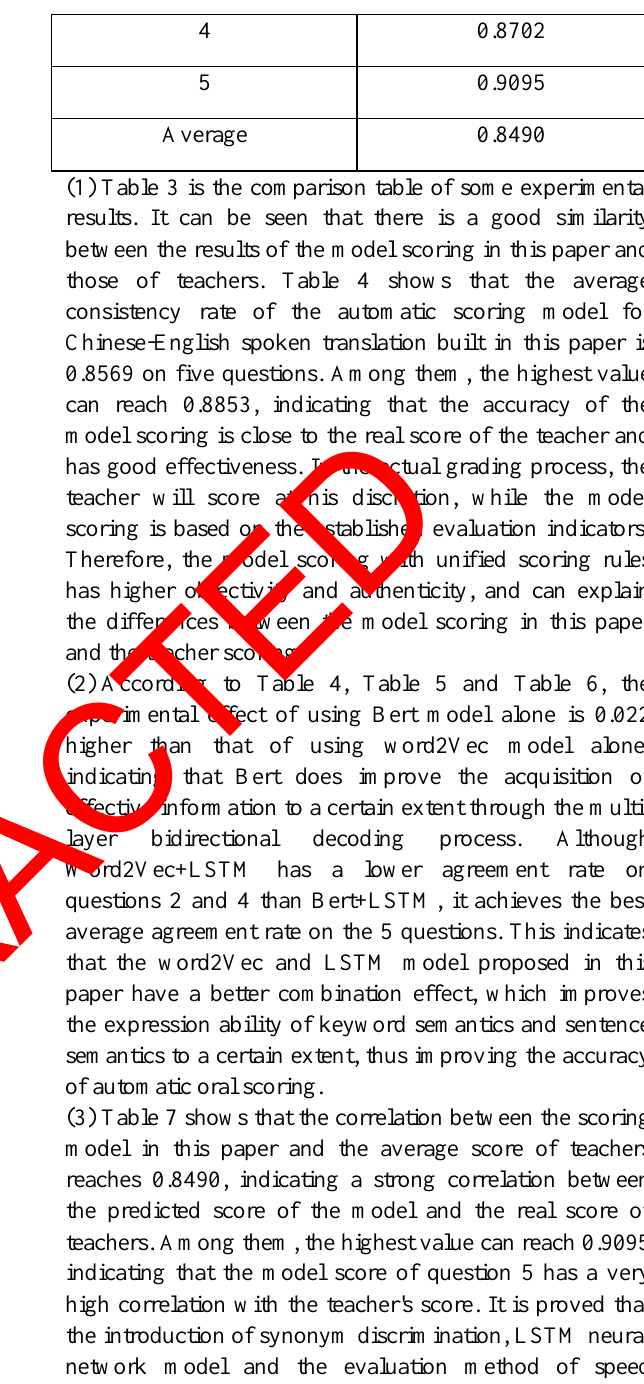
Table 7. The correlation between the model score and the teacher